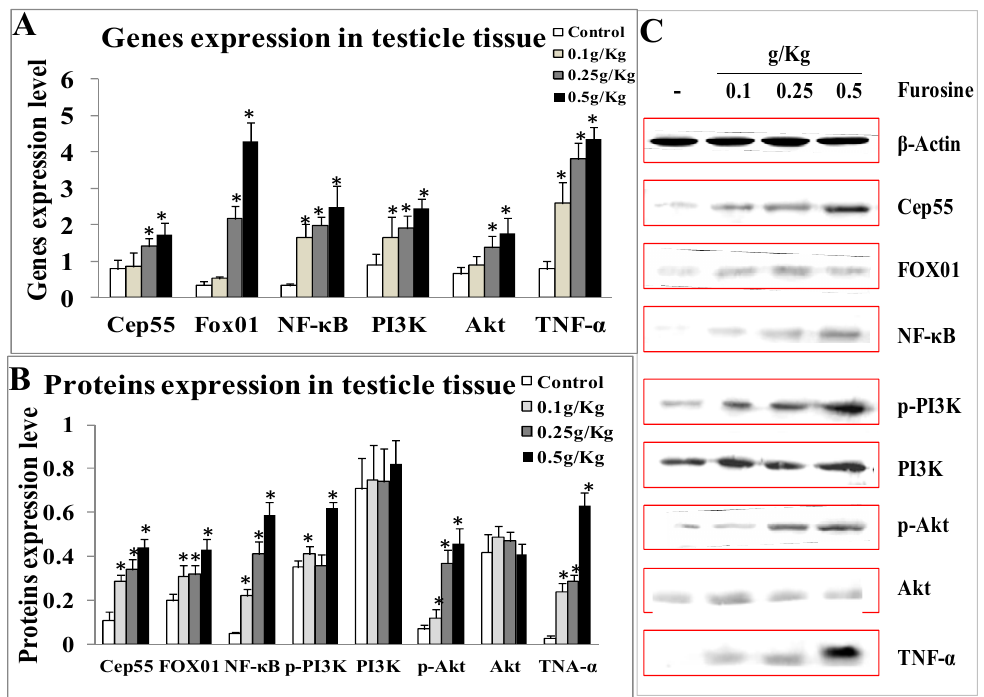
Figure 5. Expression of Cep55, NF- κ B, (p-)PI3K / (p-)Akt, (p-)FOX01 and TNF- α at both mRNA level and protein level in testicle tissue. ( A ) Genet expressions of these factors (analyzed by software). ( B ) Proteins expressions of these factors analyzed by software. ( C ) Images of these proteins by western blotting. All the data were represented as mean ± SD, n = 3. * Comparing with the control, p < 0.05.